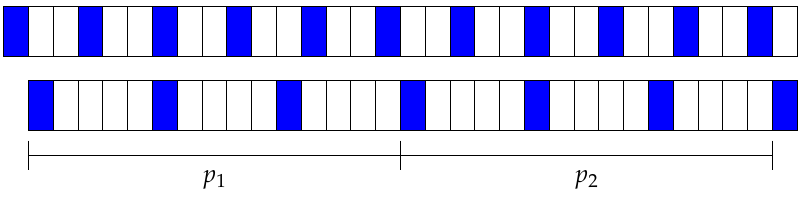
Figure 2. Example of the phases in deterministic neighbor discovery